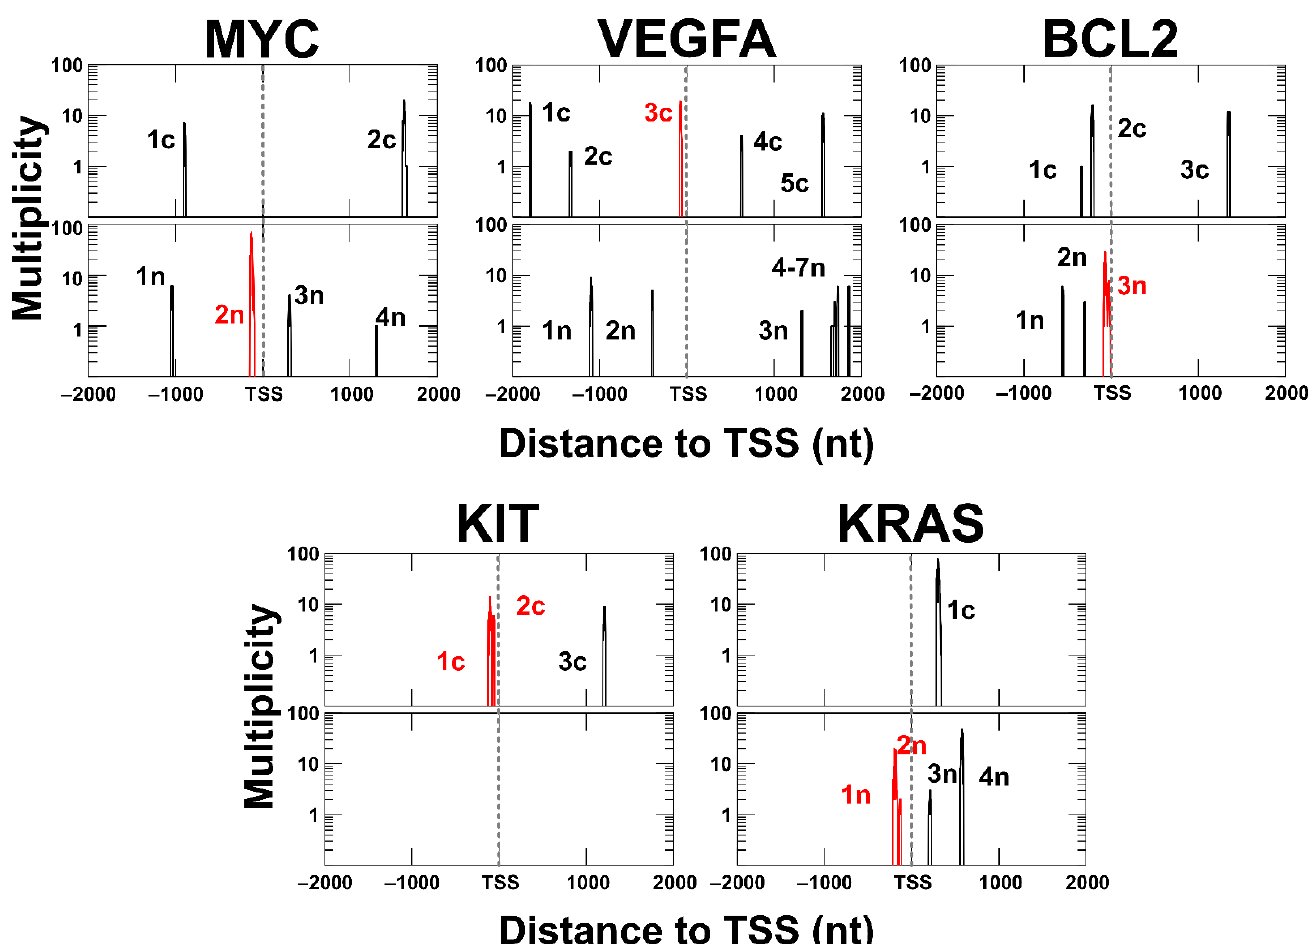
Figure 7. Multiplicities of G residues located within promoter regions of biologically relevant genes discussed in this paper plotted as a function of position relative to the transcription start site (TSS). The coding strand is shown as the top panel and all G4CRs are labeled with a lowercase c. The non-coding strand is the bottom panel, and all G4CRs are labeled with a lowercase n. G4CRs were numbered from left to right, and multiplicity is plotted on a logarithmic scale. The G4CR corresponding to the most discussed in the literature is shown in red for each gene.